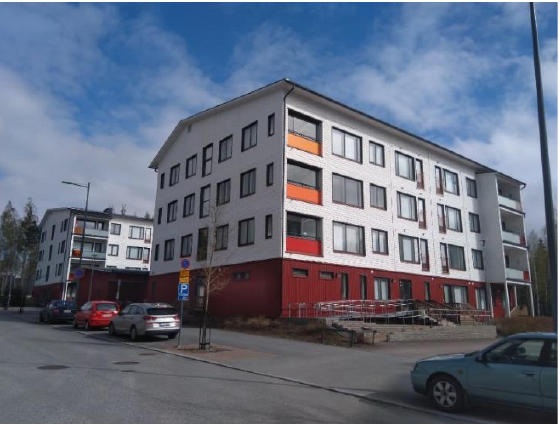
(Figure 4), VTS — Rautalepänkatu 2, Isokuusi (n = 12) (Figure 5), As Oy Tampereen Tuohi — Toivonkuja 3, Härmälä (n = 3) (Figure 6), As Oy Tampereen Tohtori — Tieteenkatu 9, Hervanta (n = 11) (Figure 7), As Oy Tampereen Härmälänsydän — Tarmonkuja 4, Härmälä (n = 9) (Figure 8), As Oy Tampereen Niemenrannan Rantapuisto — Raamikatu 32, Niemenranta (n = 5) (Figure 9), TOAS — Kauppi, Kuntokatu 11 A (n = 36) (Figure 10),